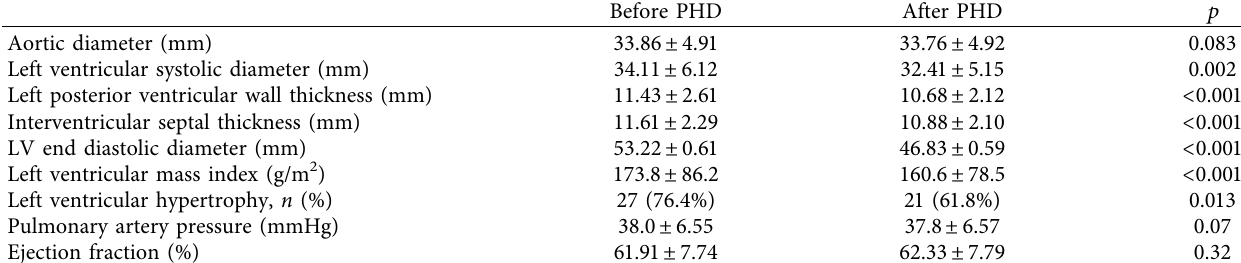
Table 3: Comparison of echocardiographic results before and after PHD.